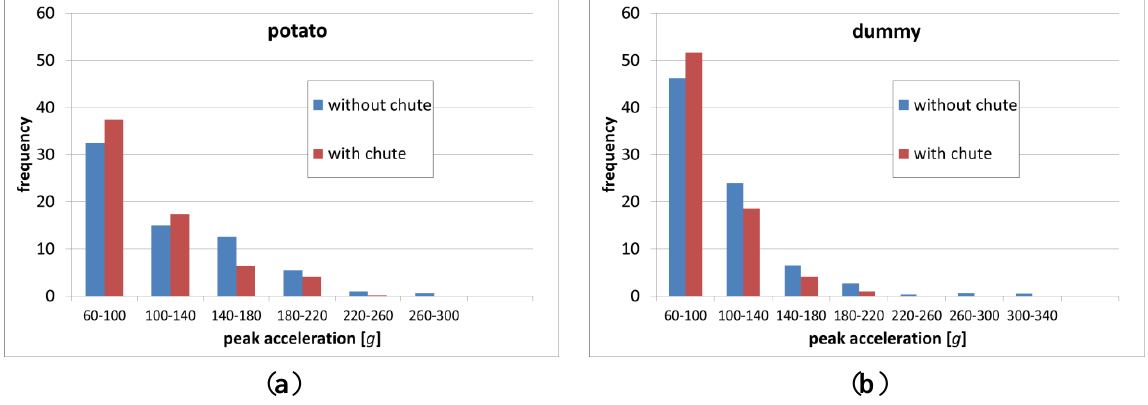
Figure 9. Frequency distribution of impacts with peak acceleration of ≥60 g measured with Mikras in a real potato ( a ) or in a dummy ( b ) during 10 runs through a processing line simulator (conveyor speed 0.35 m·s −1 ).